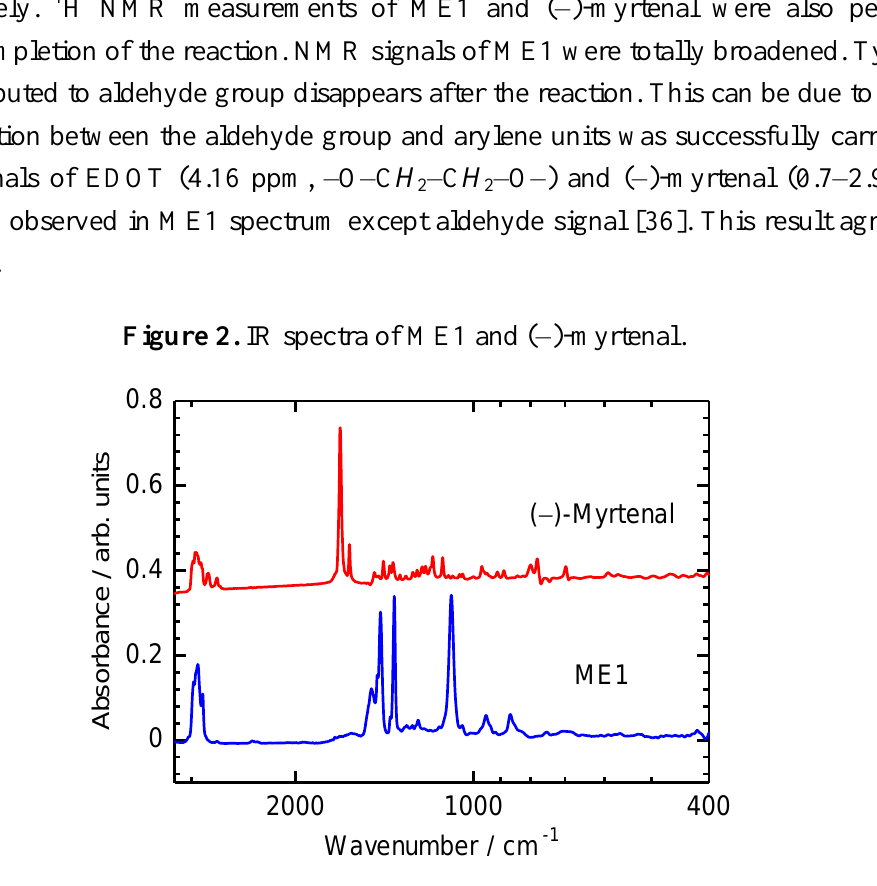
Figure 3. CD spectra of ME1 and (–)-myrtenal in CHCl